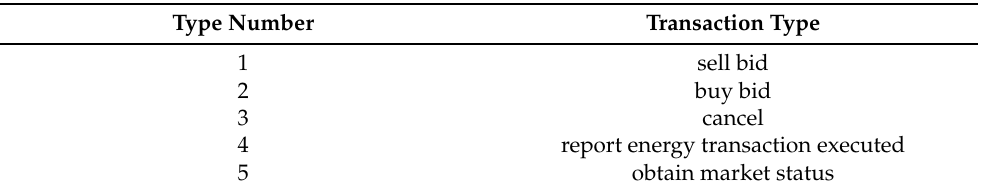
Table 1. Request types designed.